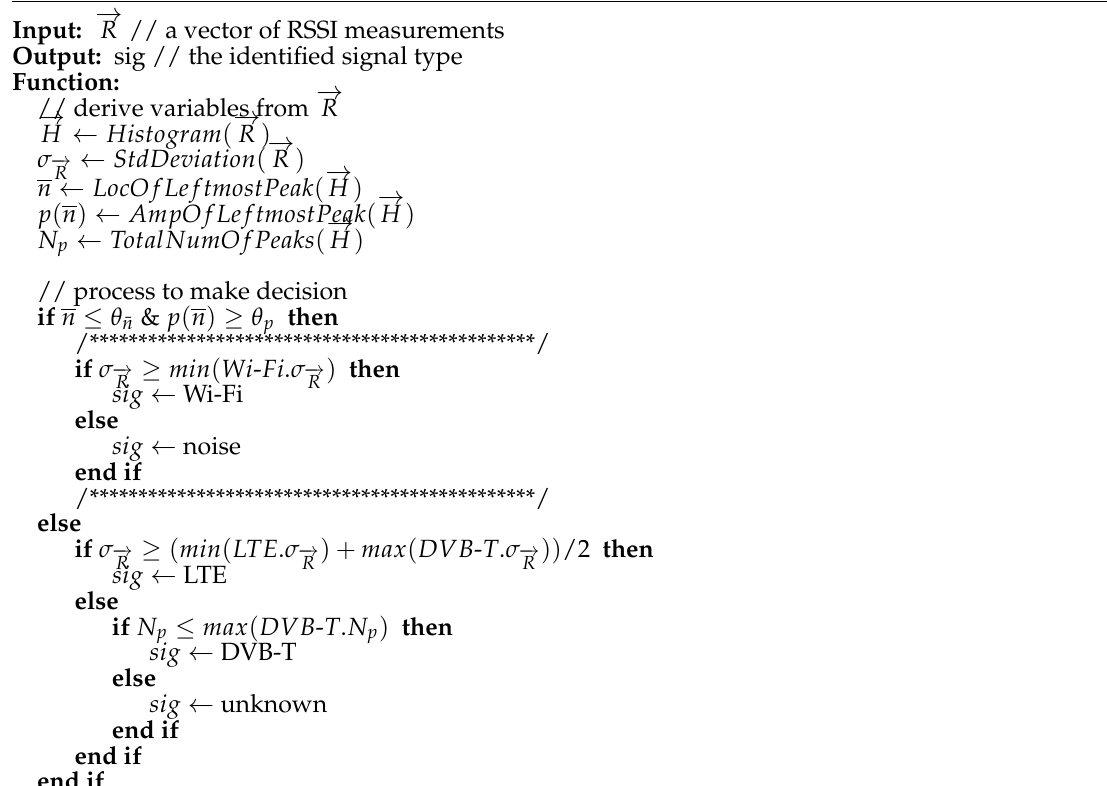
Algorithm 1 RSSI distribution-based technology